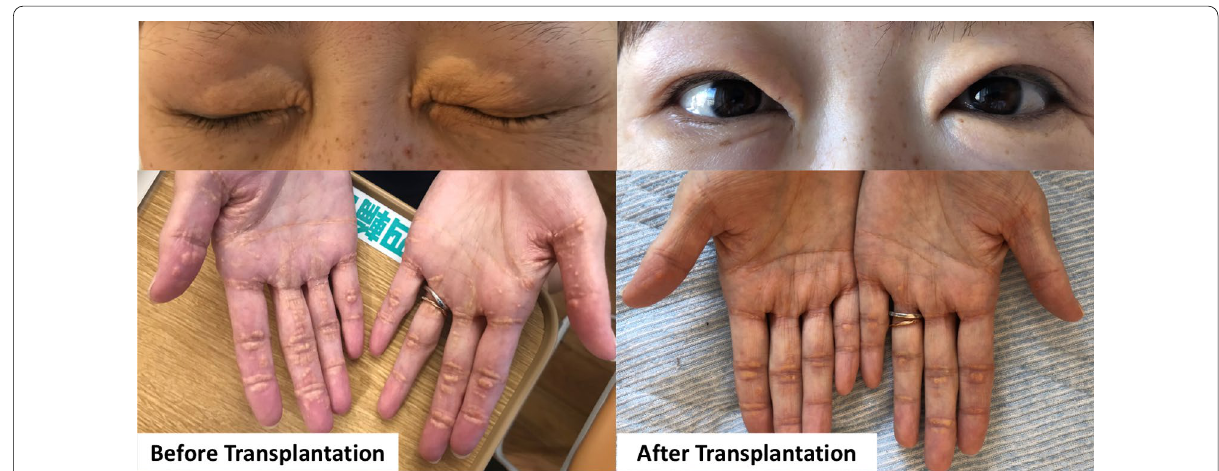
Fig. 4 Palpebral and palmar xanthomas before and after transplantation